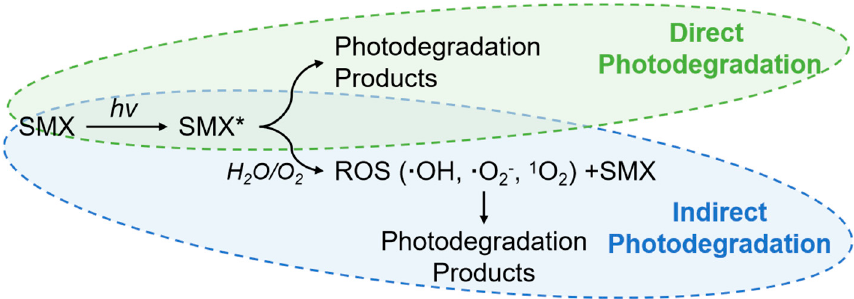
Figure 7. The proposed pathway for photodegradation of SMX.